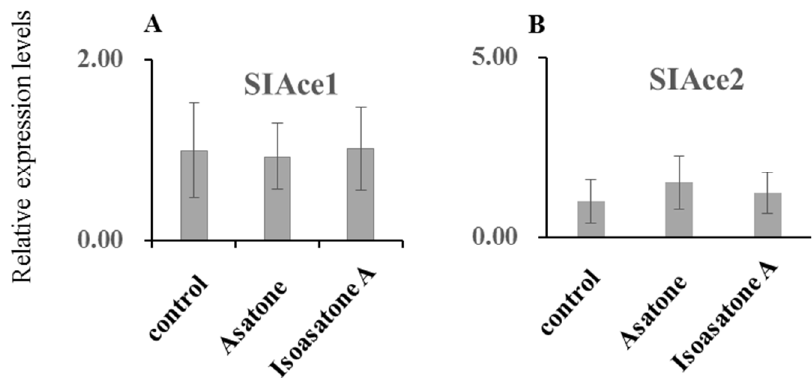
Figure 6. Expression levels of selected genes. ( A , B ) acetylcholinesterase. The β -actin gene served as an internal reference to determine relative expression levels. Data shown are mean +/ − s.e.; n = 3–5. Asterisks indicate significant differences relative to control (* p < 0.05, ** p < 0.01) in a t -test.